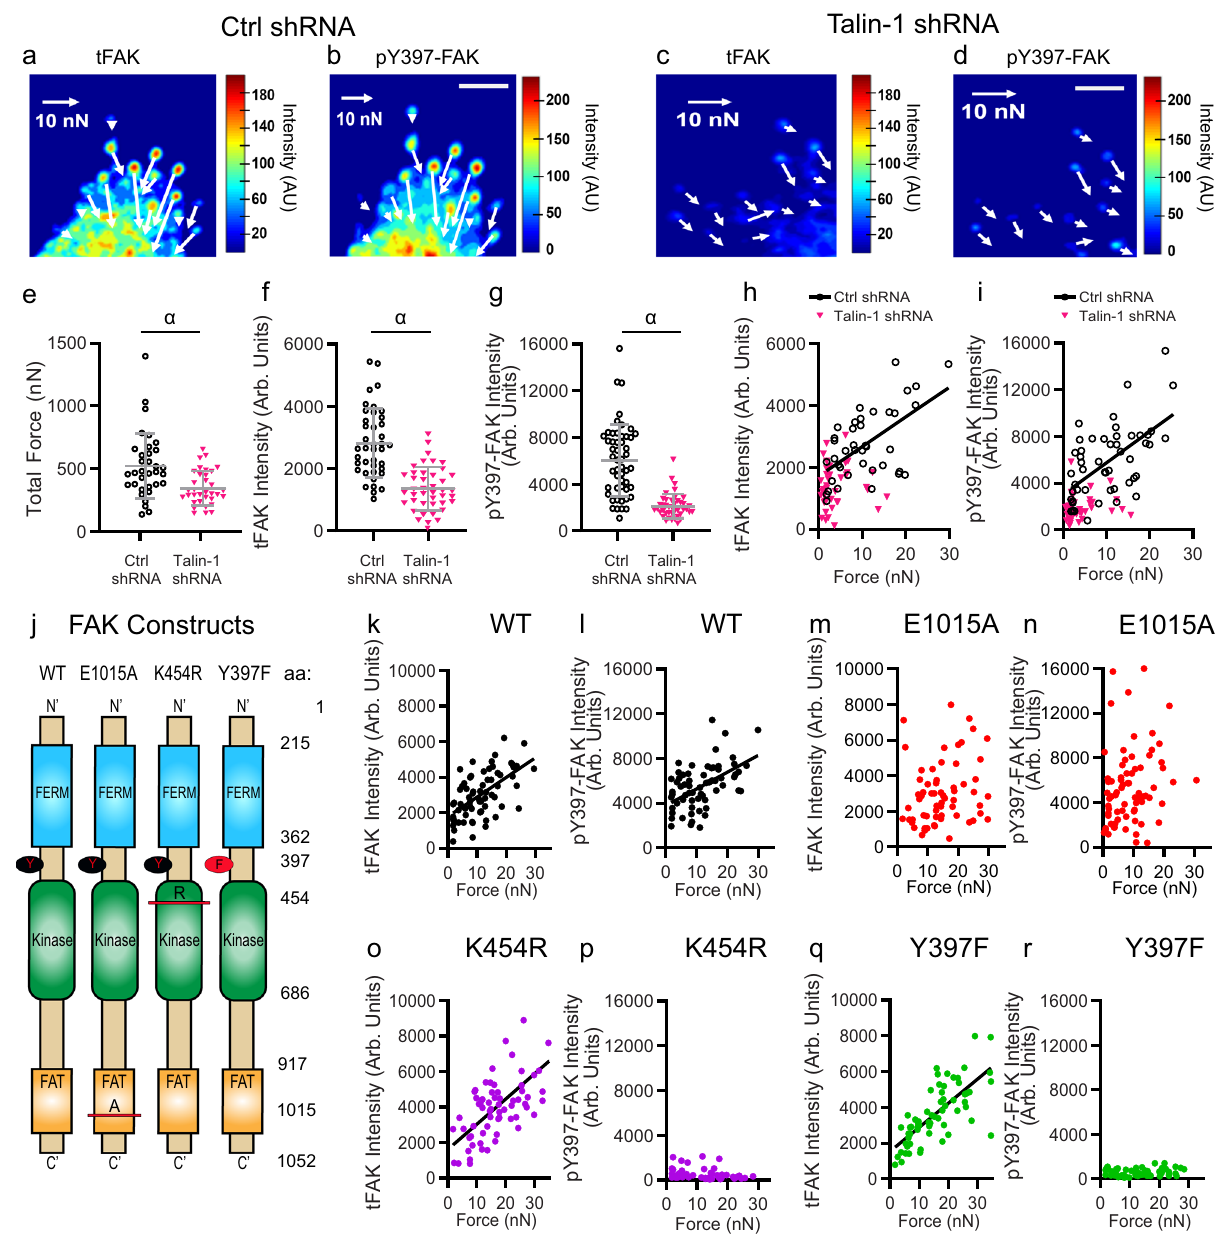
Fig. 2 Talin regulates linear force-FAK signaling coupling at FAs. a – d Heatmaps of tFAK and pY397-FAK intensities at FAs for cells treated with ( a , b